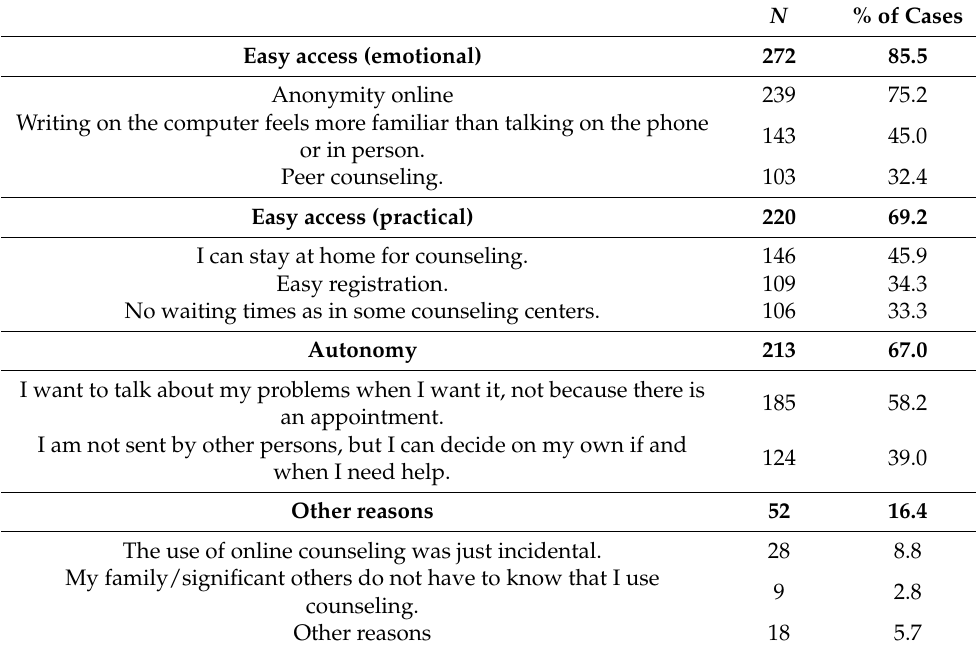
Table 4. Reasons for utilization of [U25]; only counseling clients ( n = 318); multiple